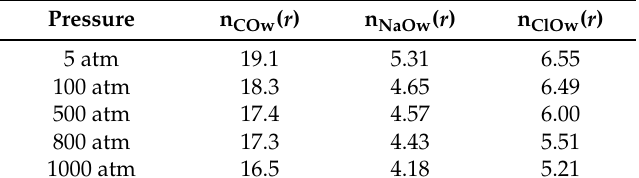
Table 4. The coordination numbers for n COw ( r ), n NaOw ( r ), and n ClOw ( r ).